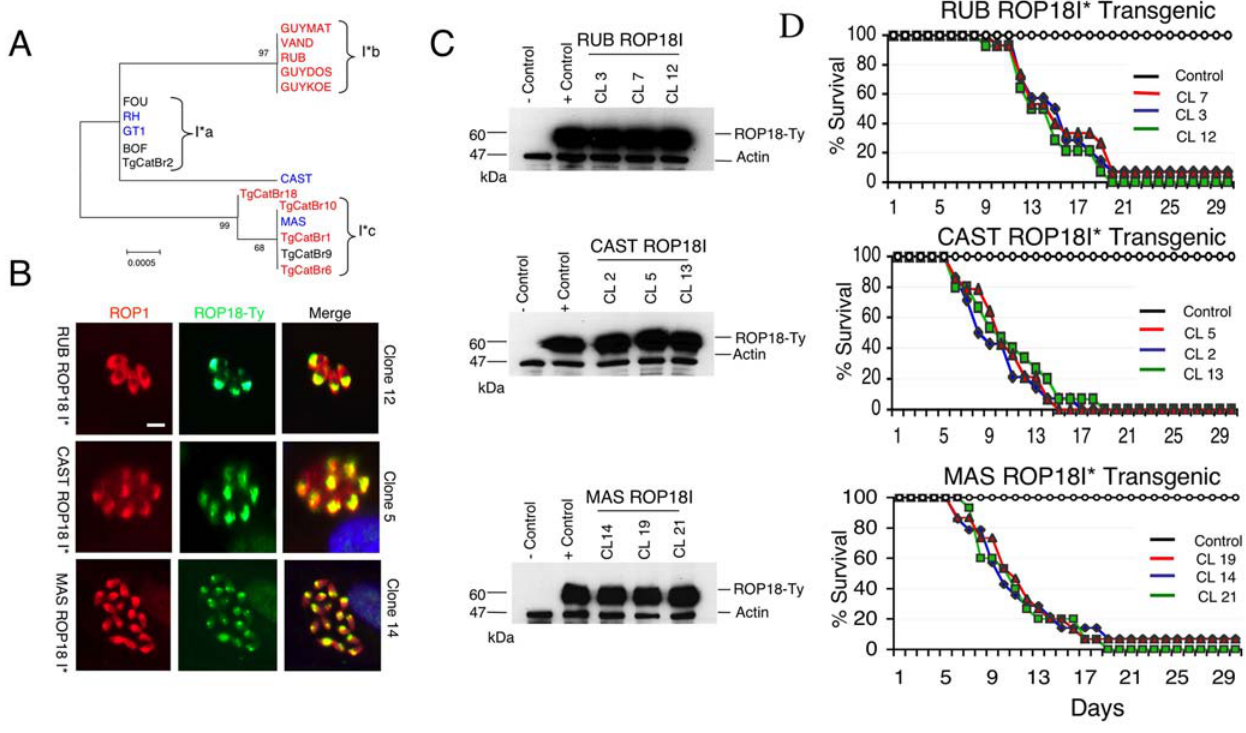
Figure 4. Newly discovered ROP18I* alleles confer acute virulence. A) Phylogenic analysis of the ROP18I* alleles reveals three major groups (denoted I*a, I*b, and I*c) plus a single node for strain CAST. Tree depicts the same data as in Figure 1B, plotted with an expanded scale. B) Expression of RPO18I* alleles in transgenic lines and colocalization with ROP1 in the rhoptries was confirmed by immunofluorescence staining. ROP18I* alleles were tagged with Ty (green) and visualized using mAb BB2. Endogenous control detected with rabbit anti-ROP1 (red). Representative clones are shown for each allele subtype of ROP18I*. Scale bar=5 microns. C) Three separate transgenic lines from representative strains as shown, expressed ROP18I* alleles at comparable levels to the previously described ROP18Ia V1 clone ( + control) [27]; vector only control ( 2 control). ROP18 was detected with mAb to the Ty-tag, rabbit anti-actin provided as loading control. D) Mouse survival assays demonstrating that expression of ROP18I* alleles in the type III background resulted in increased mortality. Cumulative mortality following challenge with 10, 100, and 1,000 parasites for each of three clones is plotted as a single line per clone (CL). Control is transgenic type III strain containing only the Ble vector.